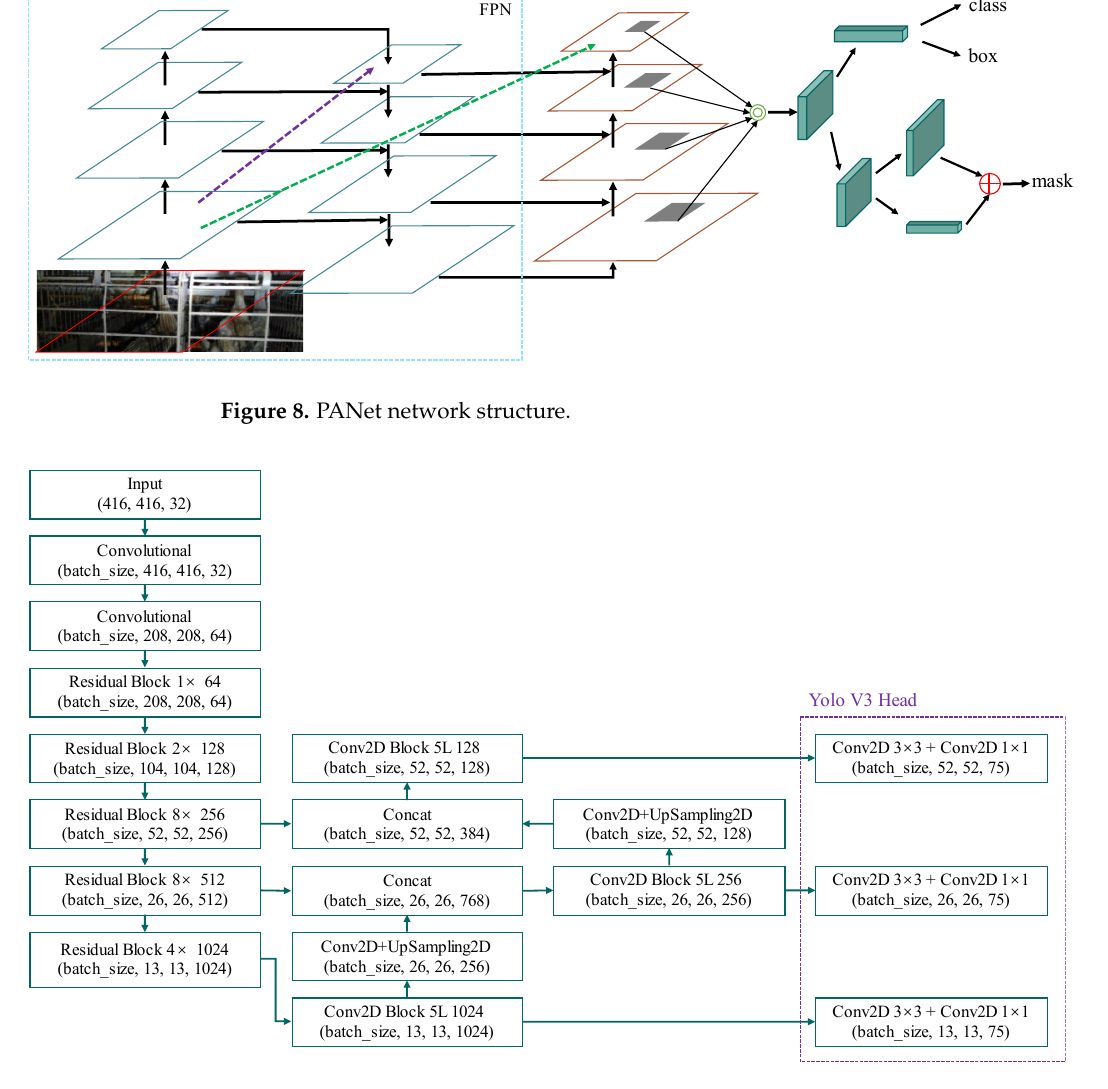
Figure 9. YoloV3 network structure.